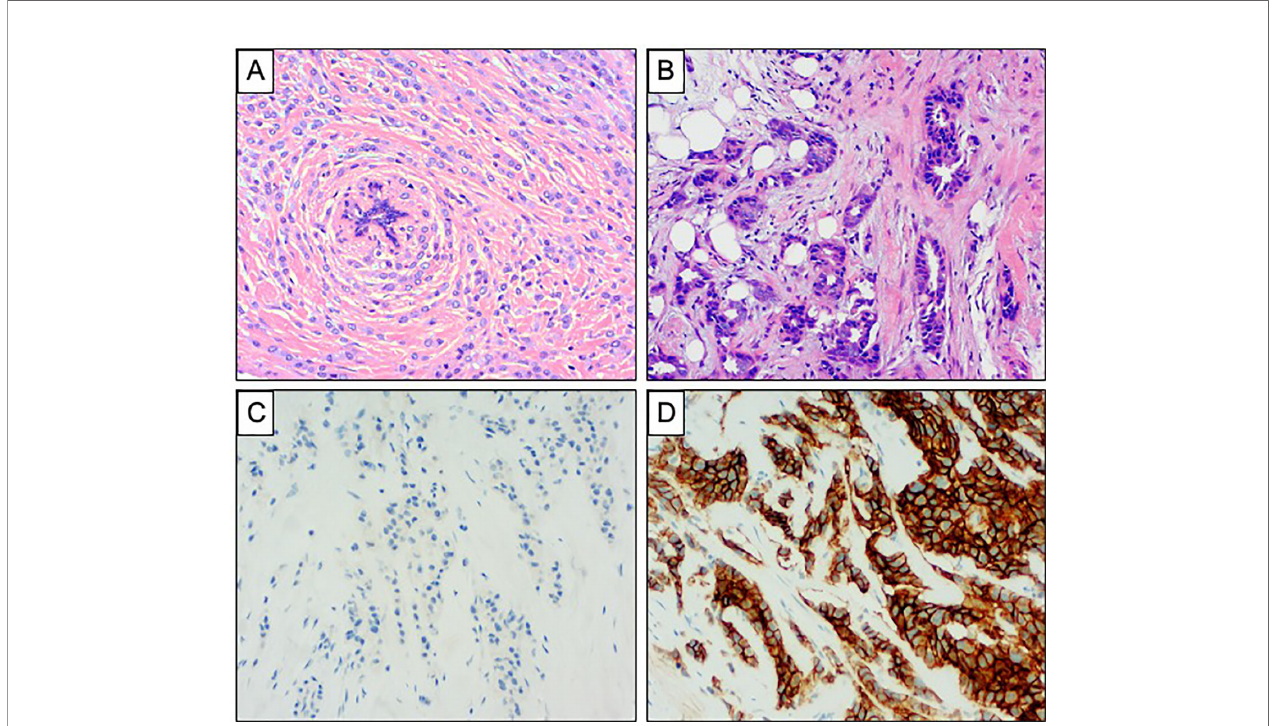
FIGURE 1 | Comparison of invasive lobular carcinoma and invasive ductal carcinoma of no special type. (A, B) Haematoxylin and Eosin stained sections demonstrating the morphology of ILC and IDC of no special type. (A) ILC showing diffuse in fi ltration of the stroma with a single fi le pattern, surrounding a normal breast duct in a concentric manner. (B) IDC showing more cohesive tumor cells forming tubules with destructive in fi ltration of the mammary stroma. (C, D) Comparison of E Cadherin expression in ILC and IDC of no special type. (C) Complete absence of staining is seen in ILC. (D) Strong and diffuse membranous expression is seen in IDC.